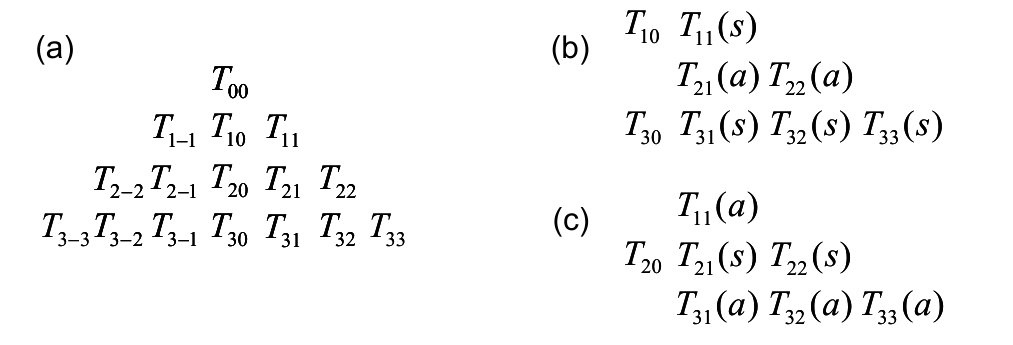
Figure A3. Complete orthogonal basis set (16 elements) describing the evolution of the spin I = 3/2: ( a ) symbolic representation T ij ; ( b ) first subset of eight independent coherences T ij ( a , s ) including the T 10 coherence; and ( c ) second subset of seven independent coherences T ij ( a , s ) including the T 20 coherence.